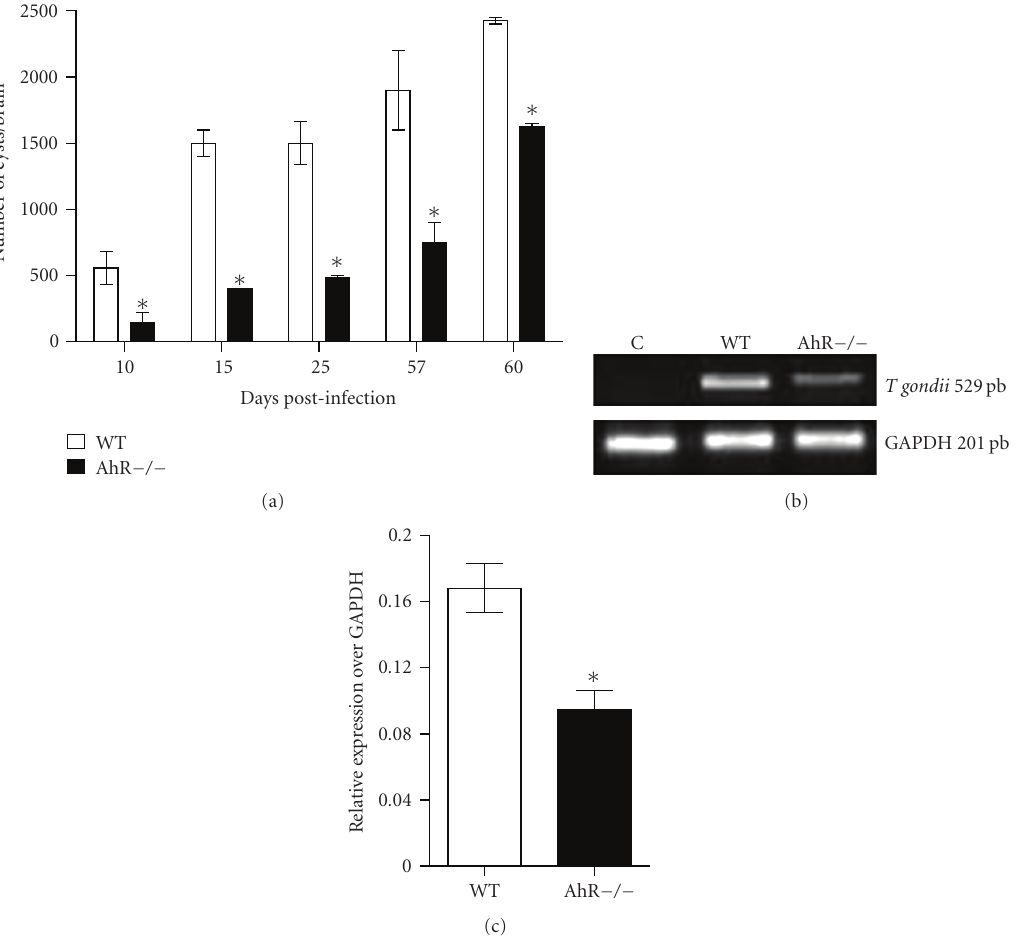
Figure 2: Parasite burden in T. gondii -infected AhR-/- and WT mice after i.p. injection with ME49 strain of T. gondii . (a) Number of cysts per brain obtained after a kinetics of days p.i. as counted under the microscope (40 X magnification). Data are representatives of three independent experiments where n = five mice per group ( ∗ P < . 01 with respect to WT, student’s t -test). (b) T. gondii gene expression by semiquantitative PCR was performed in brains of noninfected mice (letter C) and WT and AhR-/- mice at 25 days post T. gondii infection using primers specific for the sequence of the T. gondii gene: A representative gel electrophoresis from three independent experiments. (c) PCR analysis for detection of T. gondii in brains of WT and AhR-/- mice at 25 days post T gondii infection (Student’s t